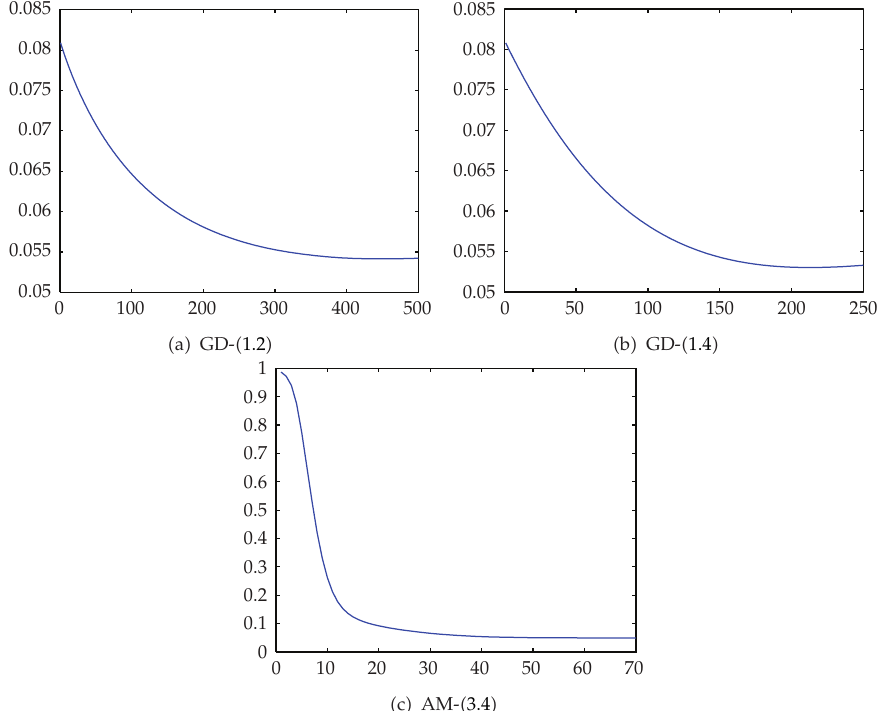
Figure 6: Recovered results by the three methods.